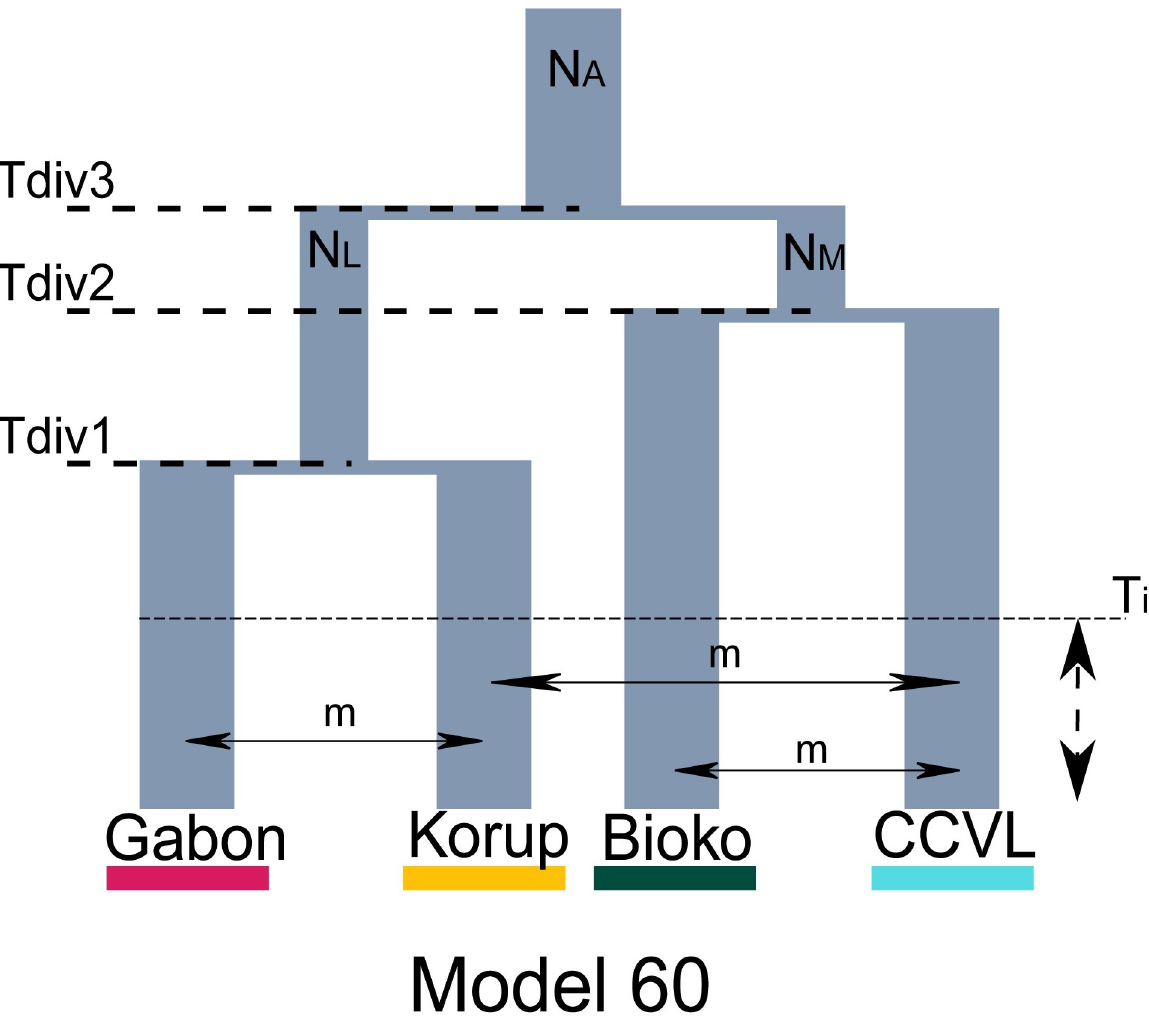
Fig 6. Results of demographic model comparisons among all four clades. The best migration and species delimitation model generated from multidimensional site frequency spectrum inferred with FastSimcoal2 implemented in DelimitR. N A : Ancestral population, N L = Lowland population, N M = montane population, T div = Divergence time, T i = Time since isolation, m = migration.